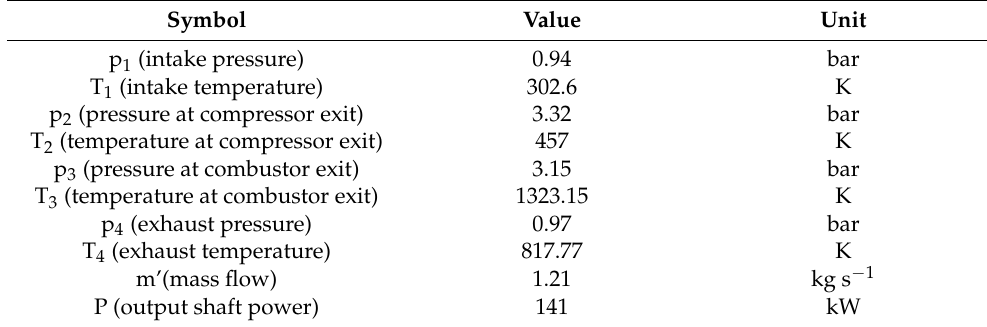
Table 1. Reference cycle data.